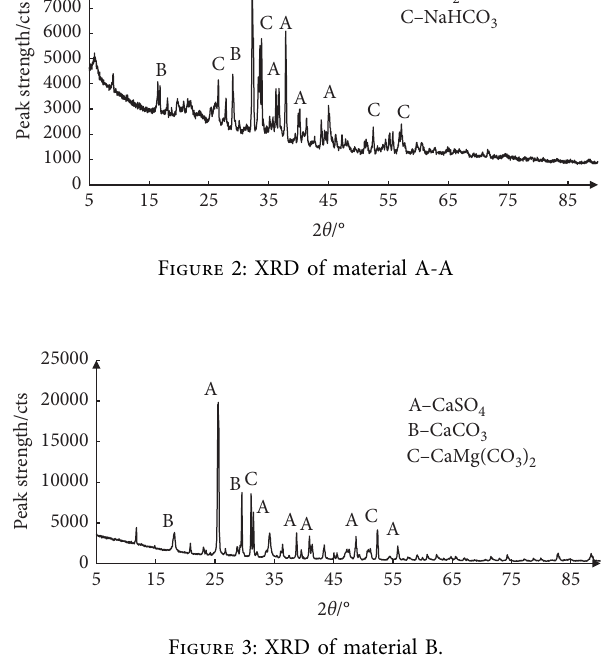
Figure 3: XRD of material B.